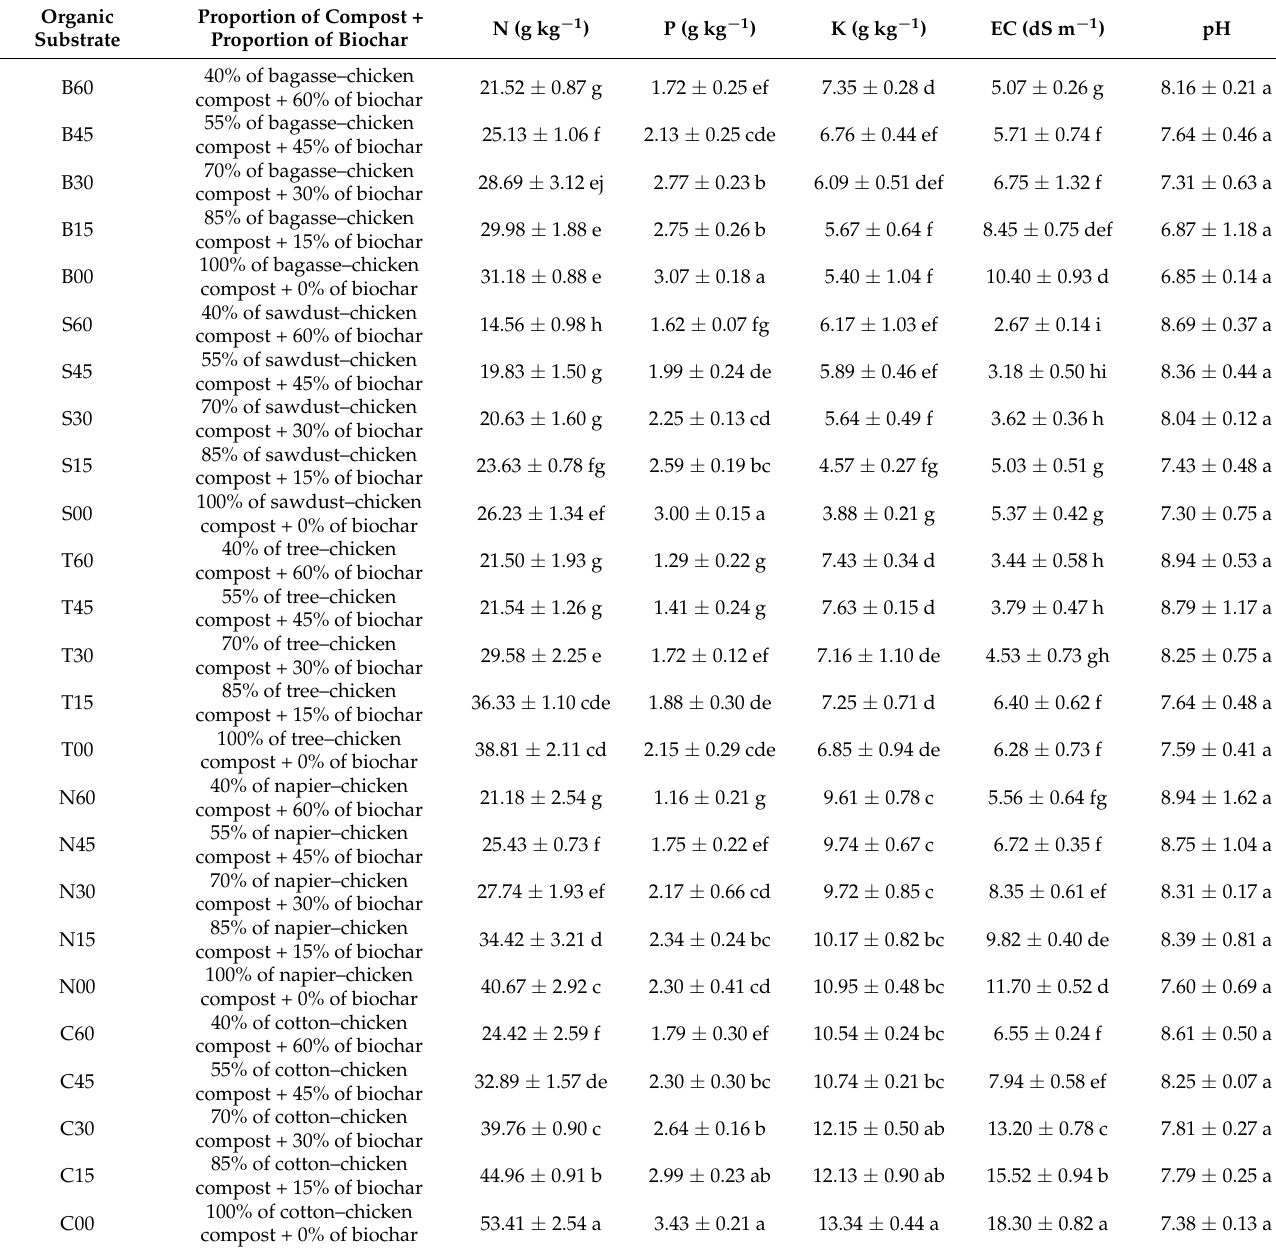
Table 1. Organic substrates used for the cultivation of parsley and their main chemical characteristics 1 . Organic Proportion of Compost + Substrate Proportion of